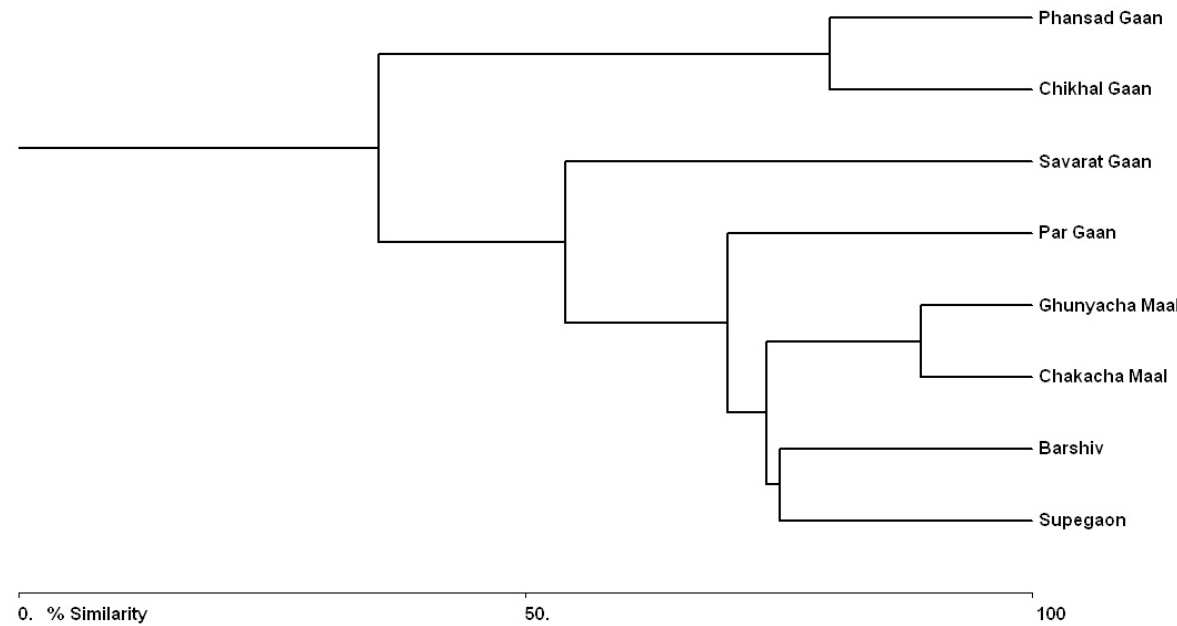
Figure 3. Dendrogram based on transect data analyzed by using Bray-Curtis similarity index, representing species assemblage structure similarity between different study areas of Phansad Wildlife